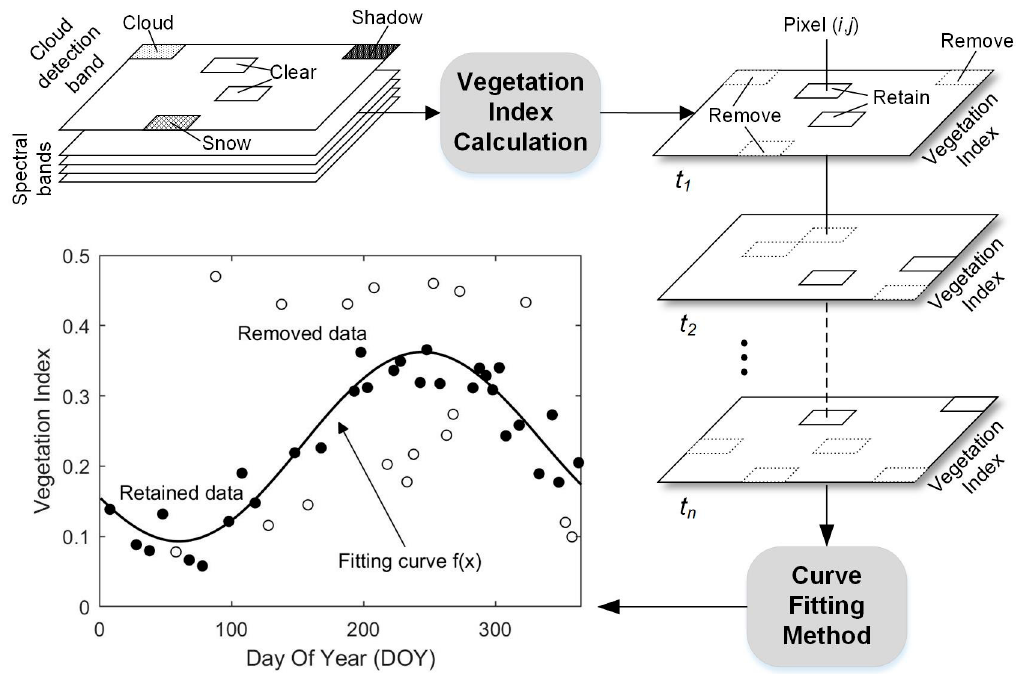
Figure 4. Summary of pre-processing methods used in the construction and application of pixel- differential time series